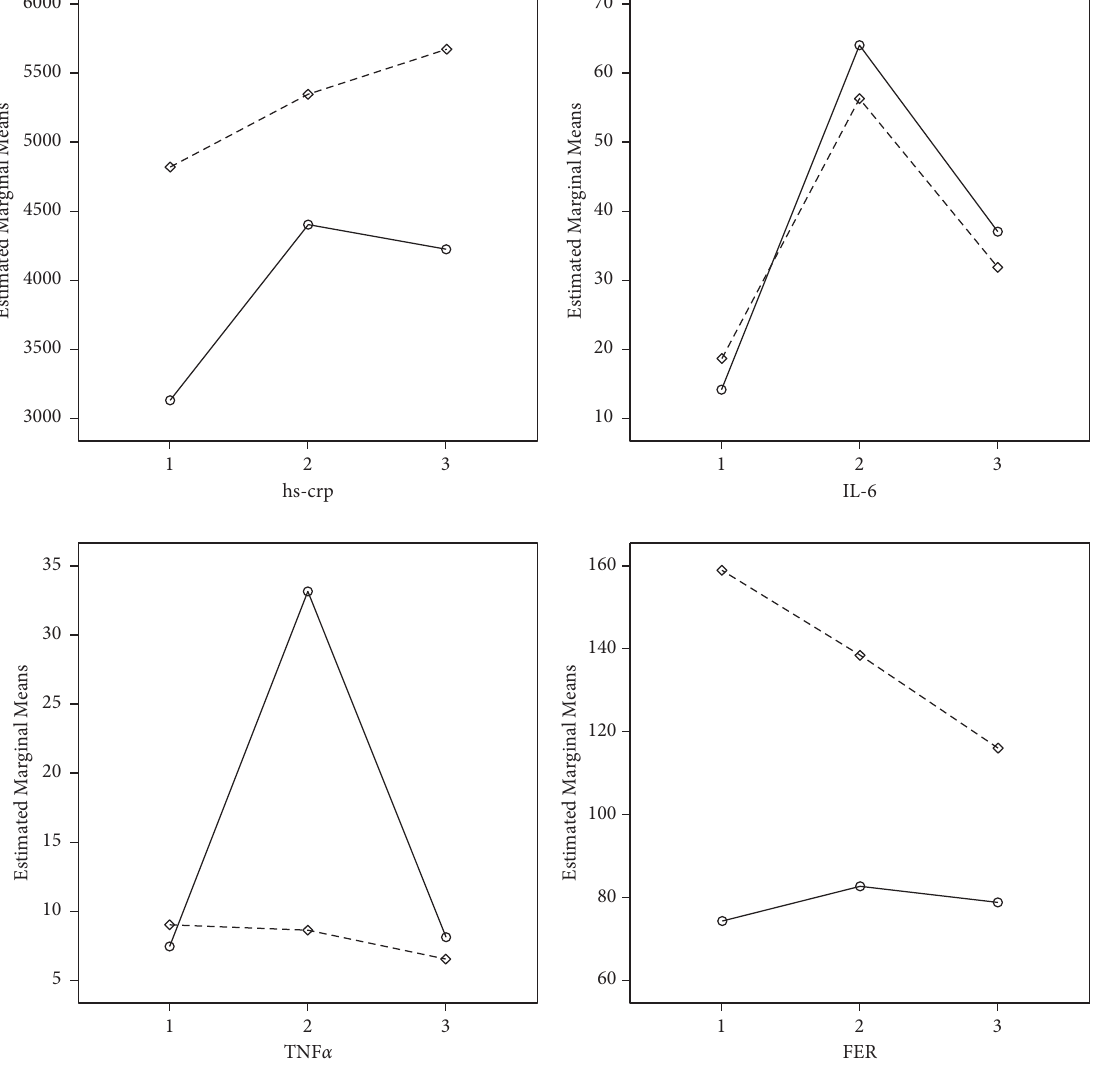
Figure 1: The pattern of changes of hs-CRP, IL-6, TNF- α , and ferritin [26] during the study period in two groups. Solid line and dash line show the general and spinal anesthesia, respectively.